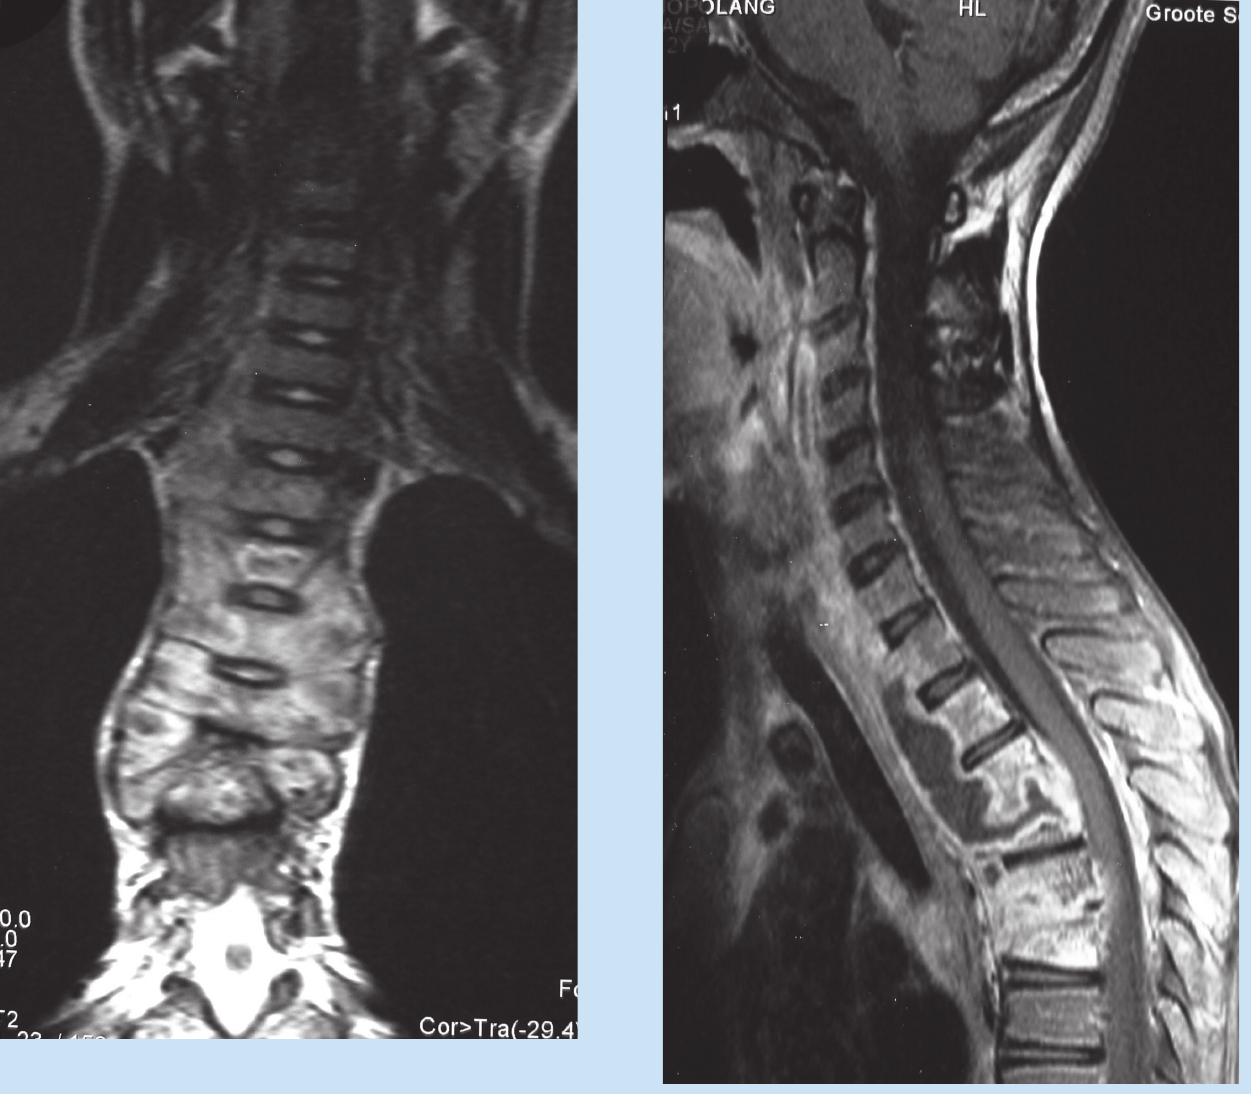
Fig. 6. A 10-year-old boy with TB spondylitis. (a) Sagittal T1 post-gadolinium and (b) coronal T2-weighted images show multiple contiguous vertebral bodies which have abnormal signal and enhancement as well as disc destruction. There is a predominantly anterior ring-enhancing soft-tissue mass but the smaller posterior extradural component causes spinal cord compression.